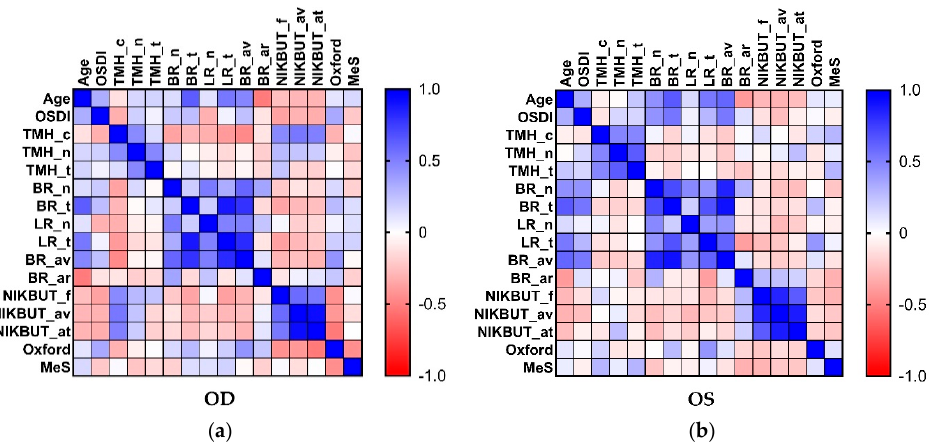
Figure 5. Spearman correlation matrix between different ocular surface homeostatic markers in the ipsilateral eye. ( a ) right eye ( N = 23); ( b ) left eye ( N = 23). Abbreviation: OSDI, ocular surface disease index; TMH_c, central tear meniscus height; TMH_n, nasal tear meniscus height; TMH_t, temporal tear meniscus height; BR_n, nasal bulbar redness score; BR_t, tem- poral bulbar redness score; LR_n, nasal limbal redness score; LR_t, temporal limbal redness score; BR_av, mean redness score; BR_ar, assessable area of ocular redness test; NIKBUT_f, non-invasive keratographic first break-up time; NIK- BUT_av, non-invasive keratographic average break-up time; NIKBUT_at, assessable time of non-invasive keratographic break-up test; Oxford, Oxford staining score; and MeS, meiboscale.